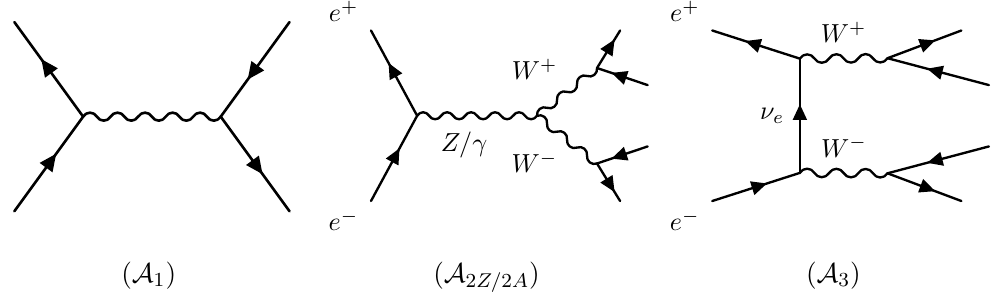
(cid:22) and doubly resonant (cid:22) !